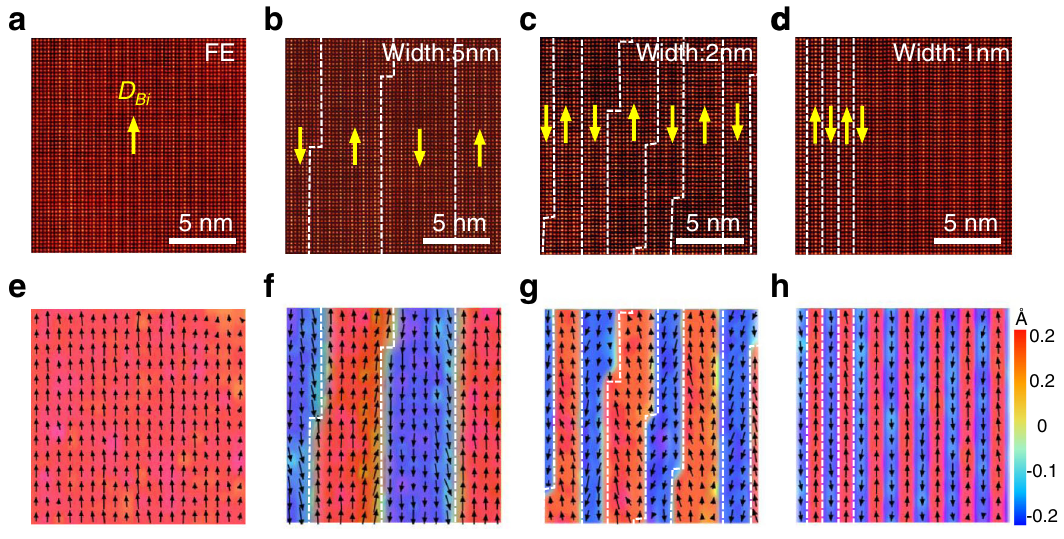
Fig. 3 | Buffered B-rows controlled domain width in Bi 2 TeO 5 . a – d Atomically resolved HAADF-STEM images of Bi 2 TeO 5 with different domain widths.